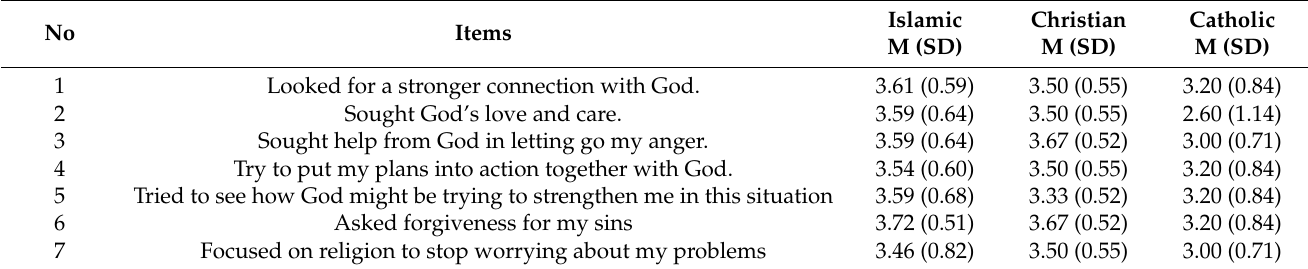
Table 2. Mean score of positive religious coping subscale items among three religions ( n = 50).